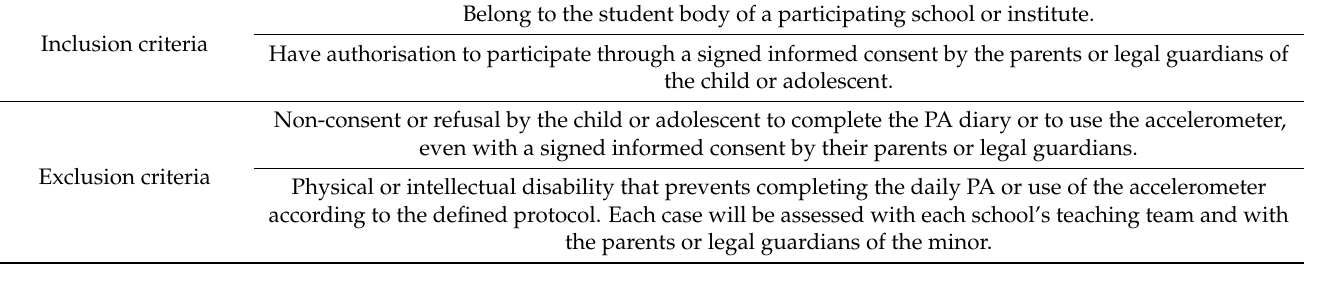
Table 1. Inclusion and exclusion